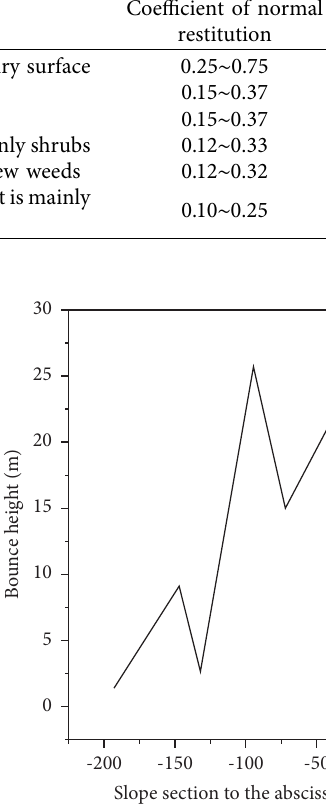
Figure 3: Trajectory of falling rock in Section 2. Figure